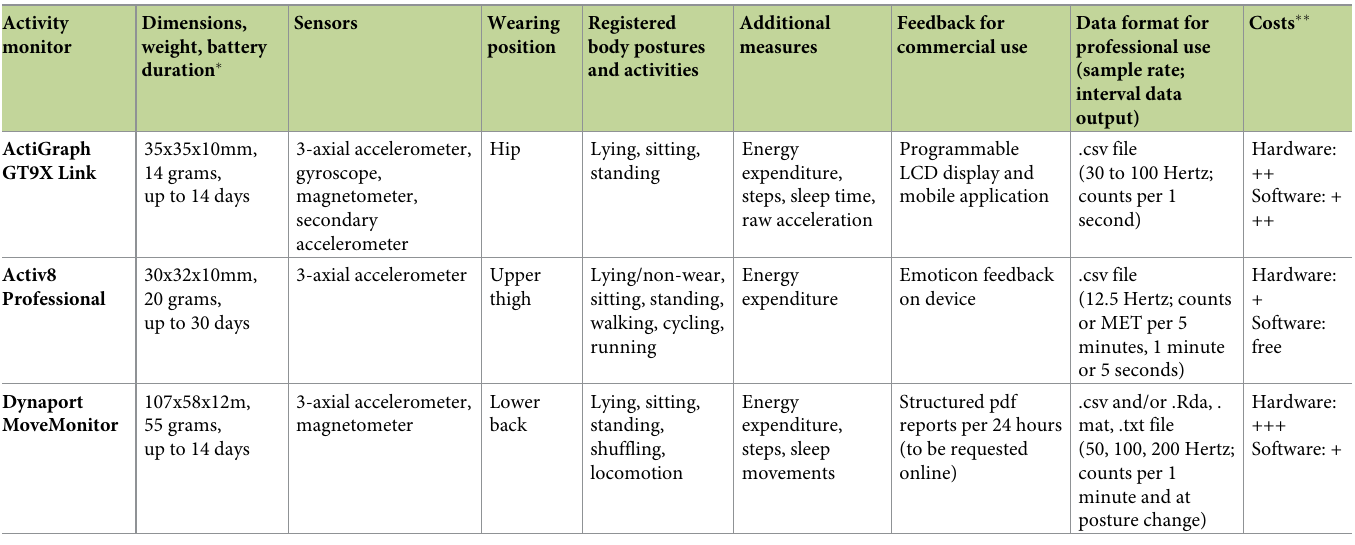
Table 2. Specifications of the